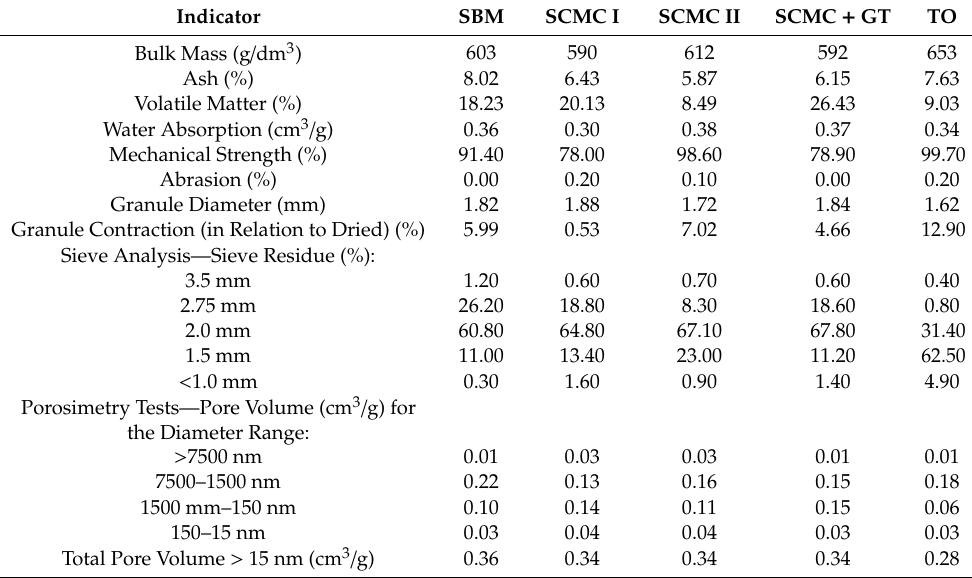
Table 7. Average properties of carbonized